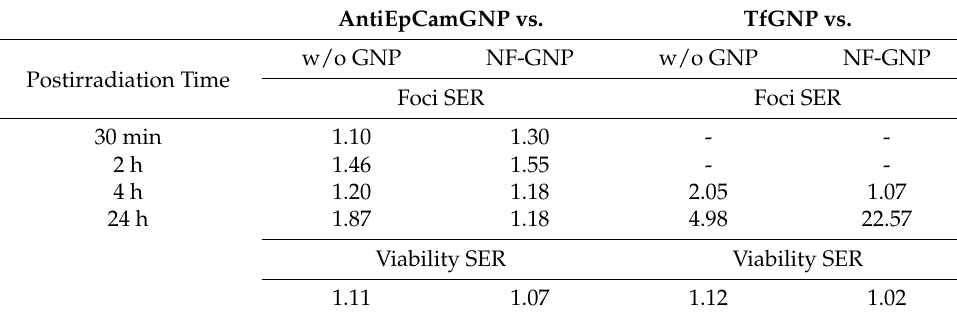
Table 1. Sensitization enhancement ratio (SER) for foci frequencies and viability. Caco2 and SKBR3 cells were irradiated at 3Gy in the presence of functionalized GNPs (AntiEpCamGNP and TfGNP, respectively) and results were compared with those after irradiation in the absence of GNPs (w/o GNP) or in the presence of non-functionalized GNPs (NF-GNP). AntiEpCamGNP vs. TfGNP vs.